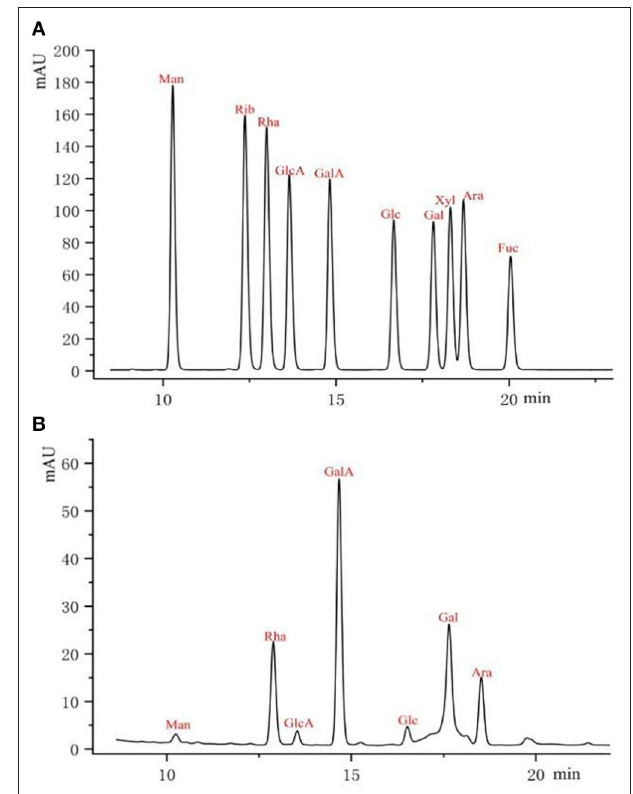
FIGURE 2 | Pre-column PMP derivative HPLC of monosaccharide standards (A) and RCHP-S sample (B) .